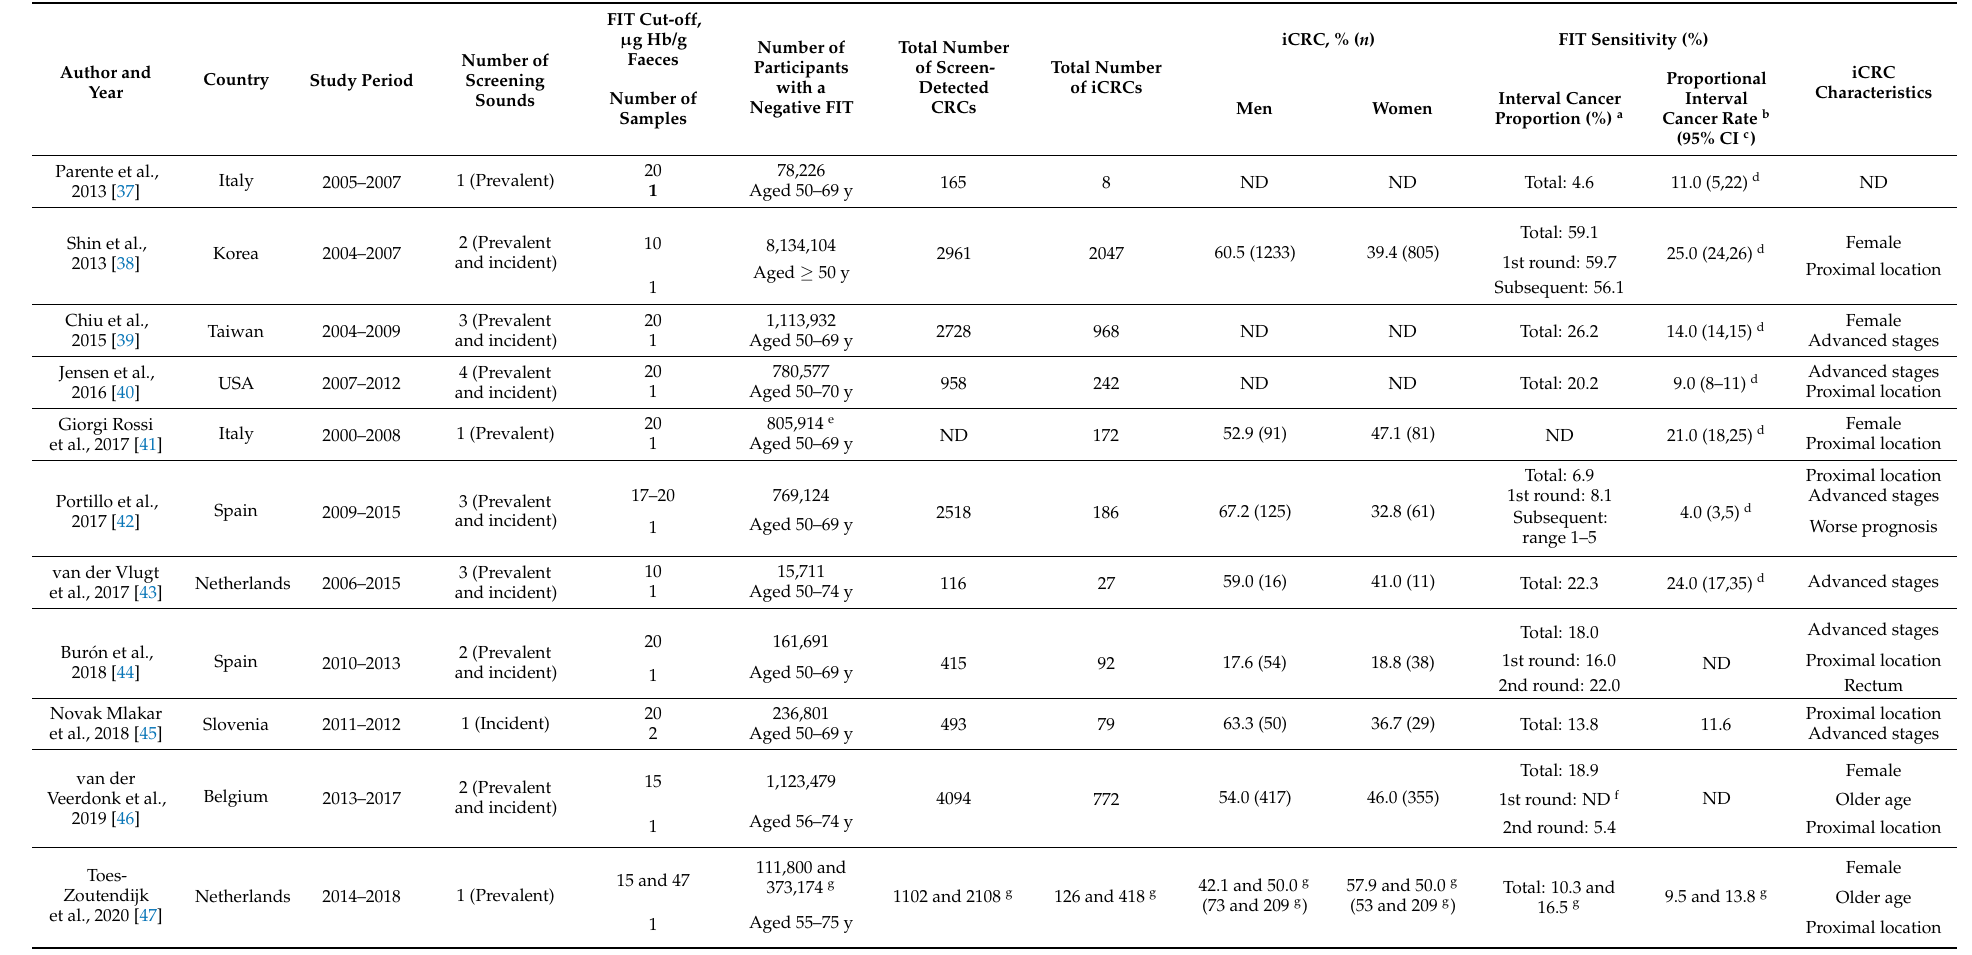
Table 1. FIT sensitivity for CRC and epidemiological and clinical characteristics associated with interval